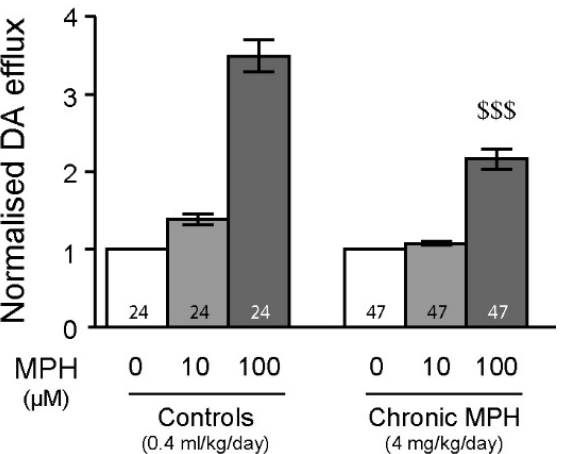
Figure 4. Chronic MPH treatment induces ex vivo long-term desensitization to subsequent MPH exposure in the striatum. Chronic treatment with MPH (4 mg/kg/day/animal for 15 days, followed by 28 days of washout) induced tolerance to subsequently applied MPH. Bonferroni post hoc tests after significant two-way ANOVAs, $$$ p < 0.001 vs. 100 µ M in controls (two-way ANOVA results: [doses of MPH]: F (2,138) = 276.4, p < 0.001; [chronic treatment]: F (1,169) = 34.04, p < 0.001, [doses of MPH x chronic treatment]: F (2,138) = 33.55, p < 0.001). n values are given for each condition and represent number of tissue samples used. DA: dopamine.